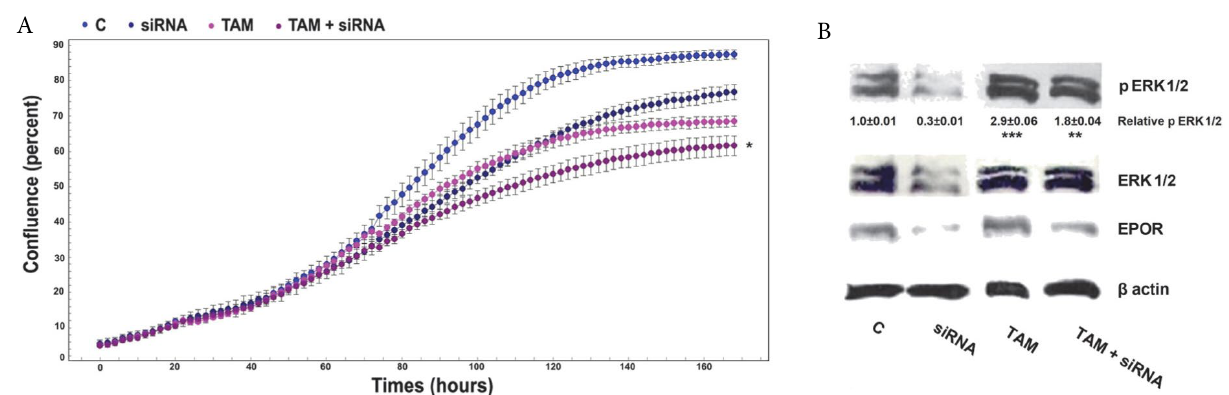
Figure 1 . The effect of siRNA against EPOR and/or TAM exposure on the proliferation and signaling of A2780 cells. Four groups of A2780 cells were set : control cells (C), cells incubated with siRNA against EPOR (siRNA), cells incubated with tamoxifen (TAM, 12.5 µM), and cells incubated with EPOR siRNA in combination with TAM (TAM+siRNA). A. Cell proliferation data were normalized through the cell index curves ± standard devia- tions of three independent experiments. Asterisk (*) designates statistically significant difference in cell proliferation between TAM+siRNA versus TAM at p <0.05. B. Western blott analysis of EPOR, ERK1/2, and phosphorylated ERK1/2 (p ERK1/2). Ratios ± standard deviations from quantita- tive densitometric analysis of p ERK1/2 were normalized to ERK1/2. Equal loading was confirmed by detection of β-actin. Ratio of C was arbitrari-